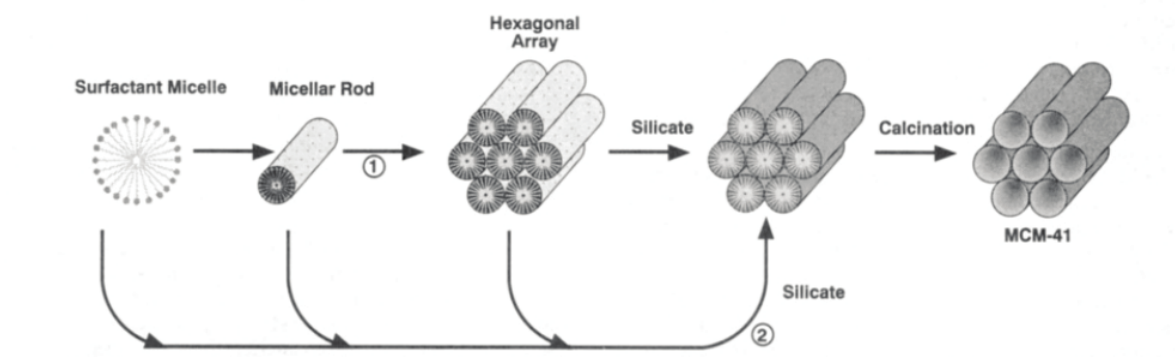
Figure 3 : (a) Oxidation of guaiacol by H haemin [65]. Reprinted with permission from Ref. [65]. Copyright © 2015, SpringerLink.